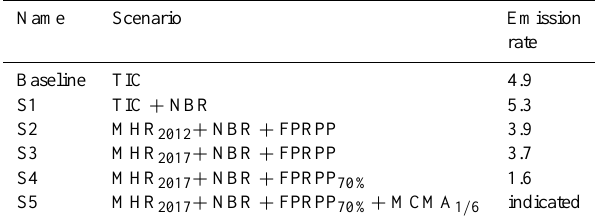
Figure 9. Estimated contribution of the Tula refinery to ozone lev- els at T1 supersite during the simulation period (blue) and flaring activities in the Refinery (green).